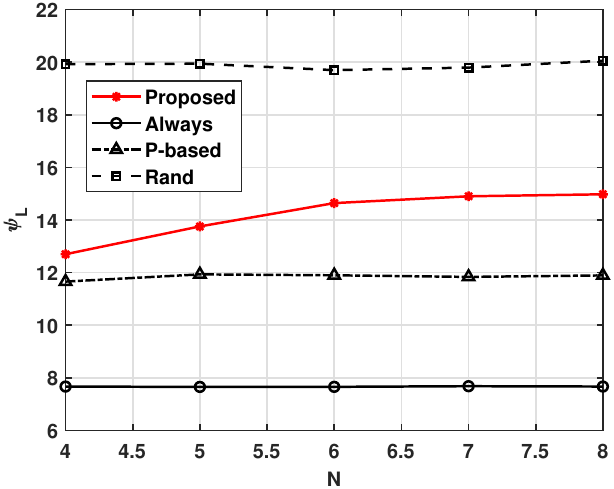
Figure 9. Cluster lifetime ψ L versus N